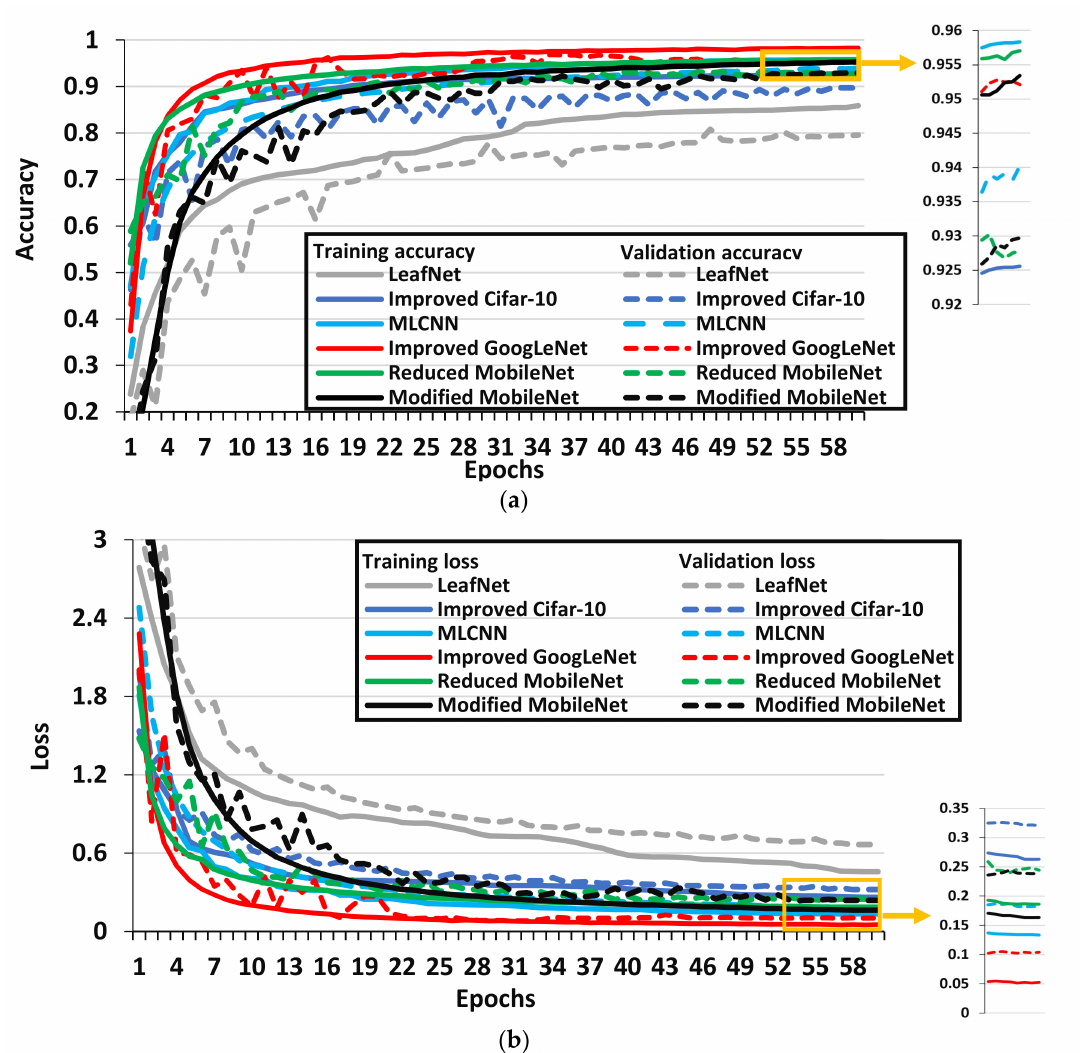
Figure 5. Performance plots of modified versions of CNN architectures. ( a ) Provides training and validation accuracy, ( b ) provides training and validation